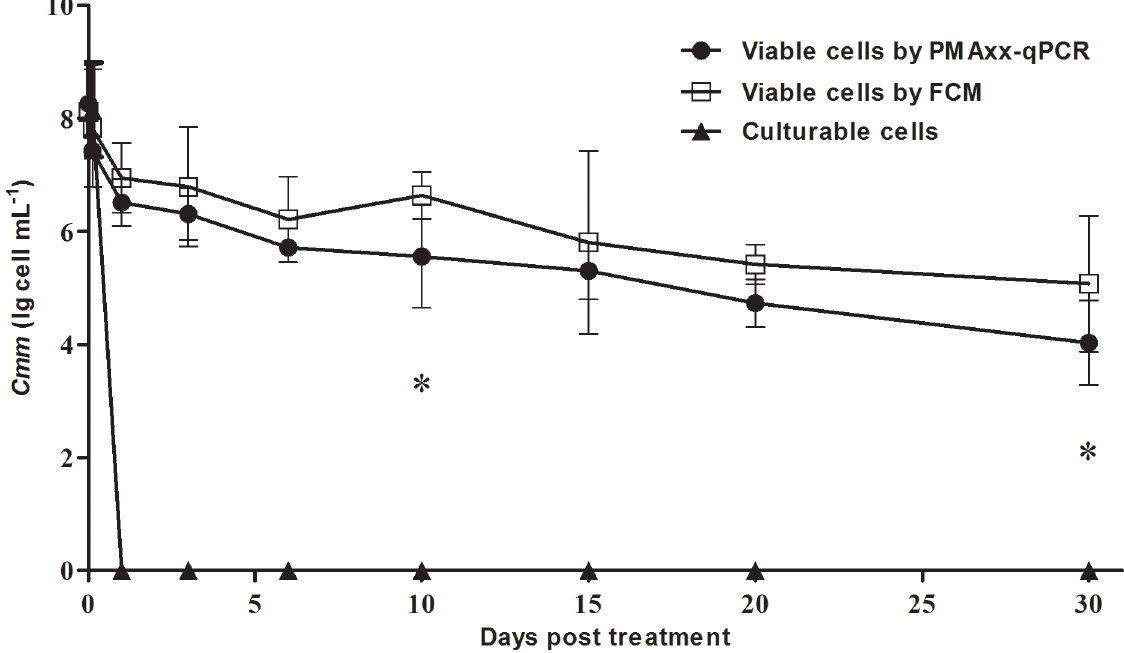
Fig 3. Detection of VBNC cells of Clavibacter michiganensis subsp. michiganensis ( Cmm ) by PMAxx-qPCR and flow cytometry (FCM). Viable and non-culturable (VBNC) cells of Cmm was induced by 50 μ M CuSO 4 in 0.85% NaCl. The bacterial cells were collected at 0 h, 3 h, 1 d, 3 d, 6 d, 10 d, 15 d, 20 d and 30 d, and used for viability detection by PMAxx-qPCR and flow cytometry method, while the culturability was determined on LB plates. Each data point represents the mean of two biological replicates. (cid:3) indicates that the means were significantly different ( P < 0.05) at the corresponding time